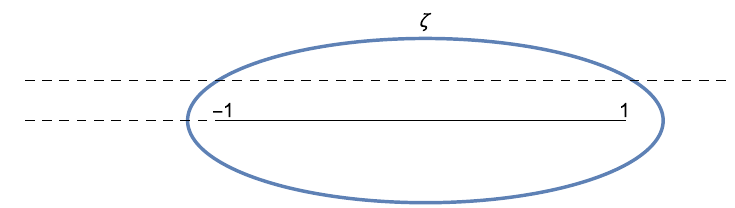
Figure 4 . The cut plane of the complex (cid:16) variable is the maximal domain of analyticity of two-point functions satisfying the spectral condition. In the periodic cases the extra dotted cut disappears. The dotted line Im (cid:16) = (cid:15) is the projection on the complex (cid:16) plane of the domain of integration in eq.